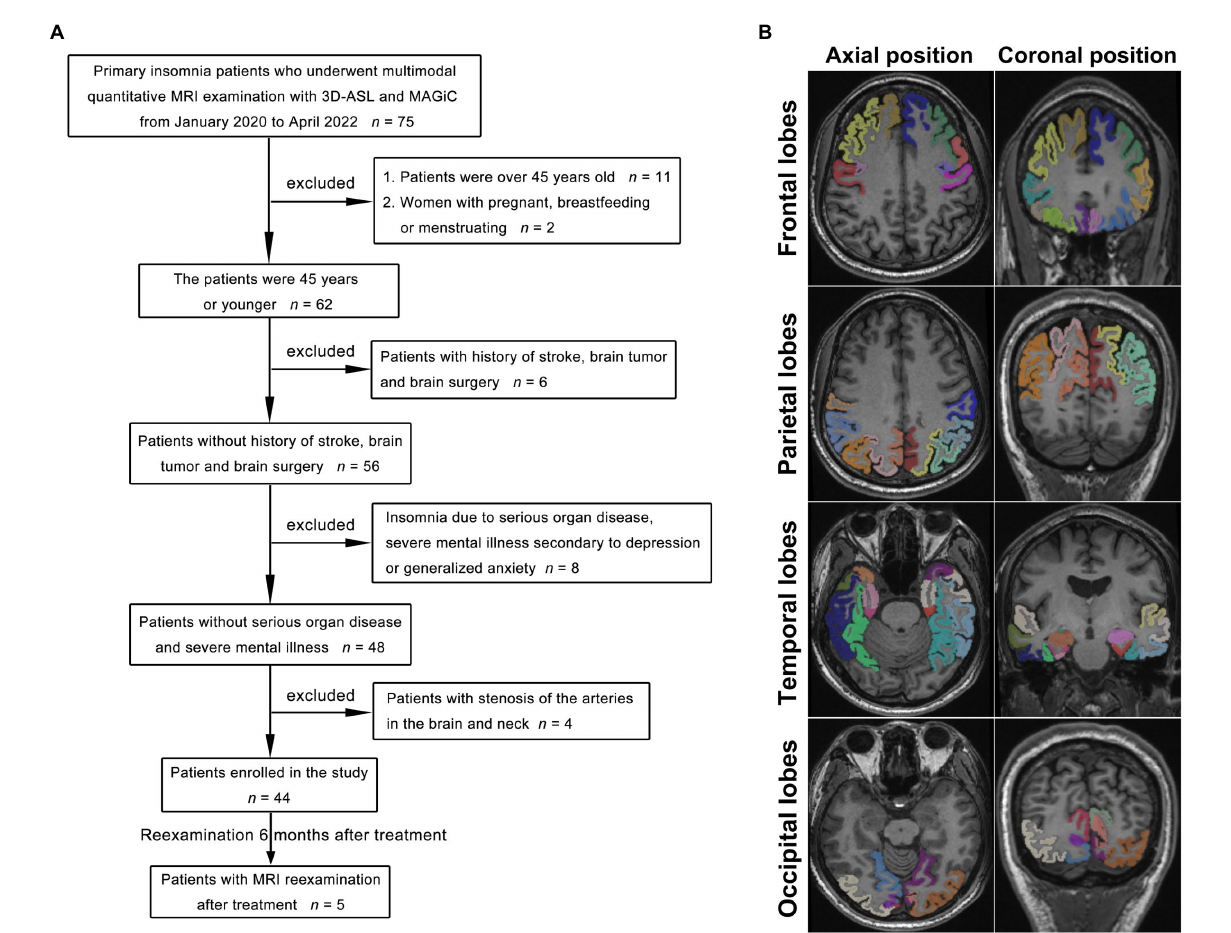
FIGURE 1 Flowchart of the PI patient selection process (A) . With the 3D-T1 images as a reference, the frontal lobe, parietal lobe, temporal lobe, and occipital lobe were accurately obtained by image segmentation as the ROIs for measurements (B) , and the different colors indicate the different gyri of the left and right